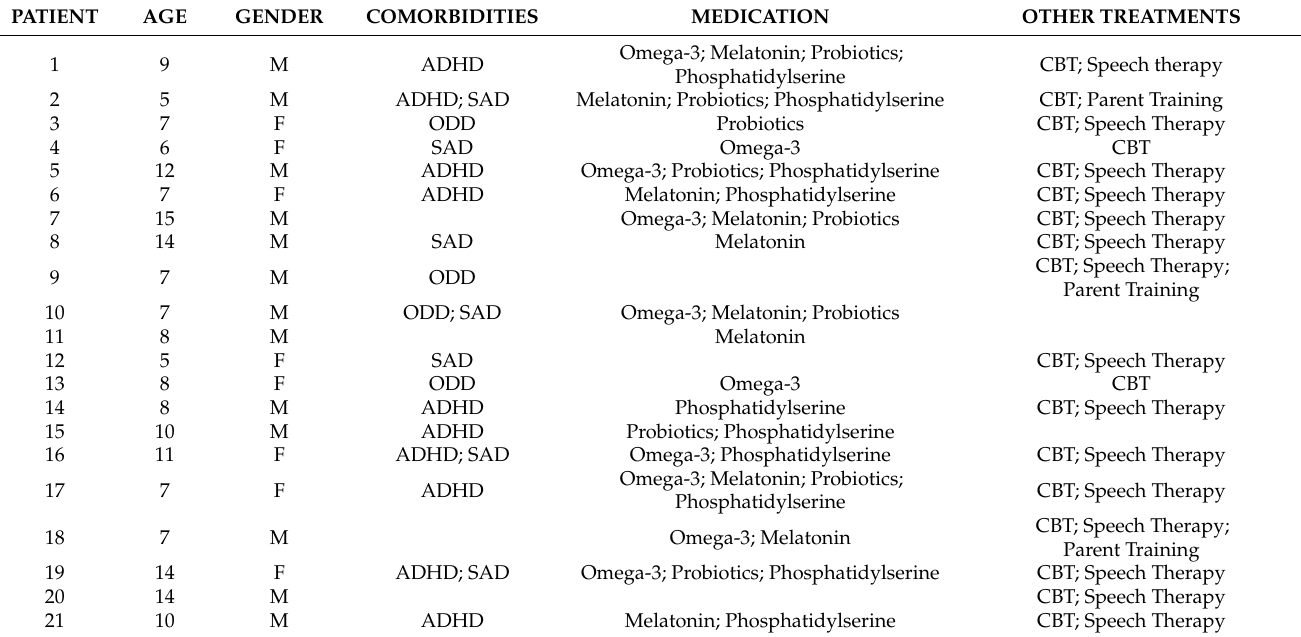
Table 1. Demographical data of the patients as well as comorbidities and ongoing treatments (ADHD, Attention Deficit Hyperactivity Disorder; SAD, Social Anxiety Disorder; ODD, Oppositional Defiant Disorder; CBT, Cognitive-Behavioral